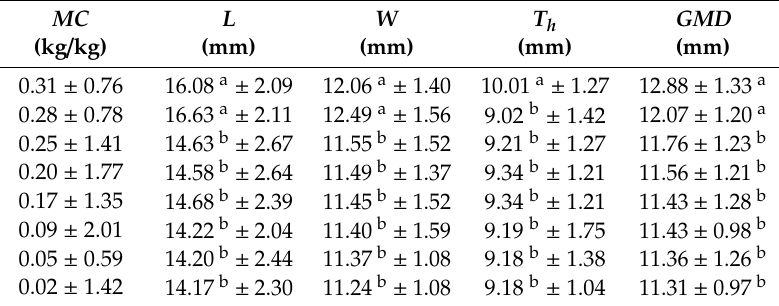
Table 3. Dimensions of palm kernel at di ff erent moisture